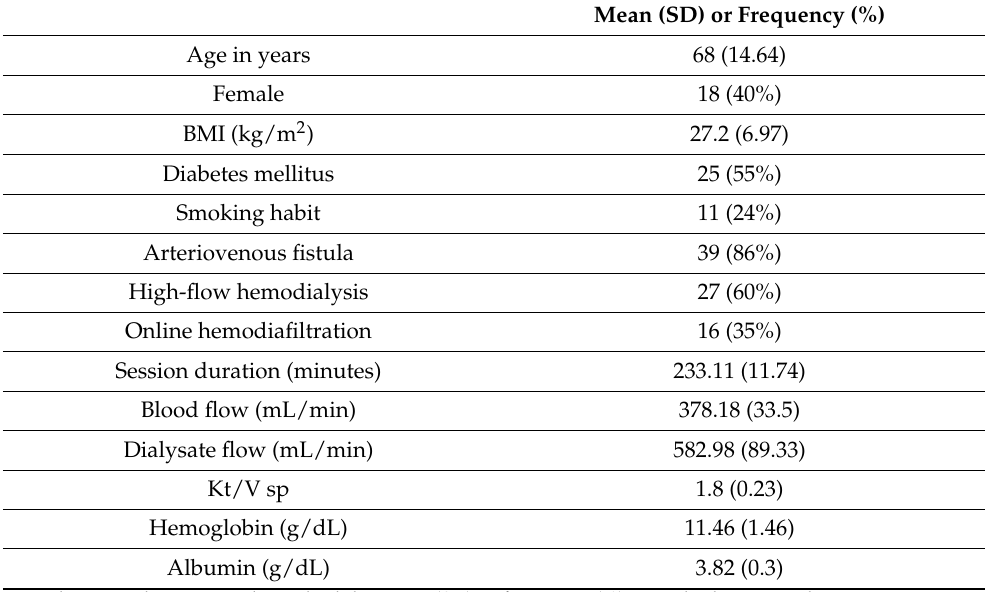
Table 1. Patient characteristics at